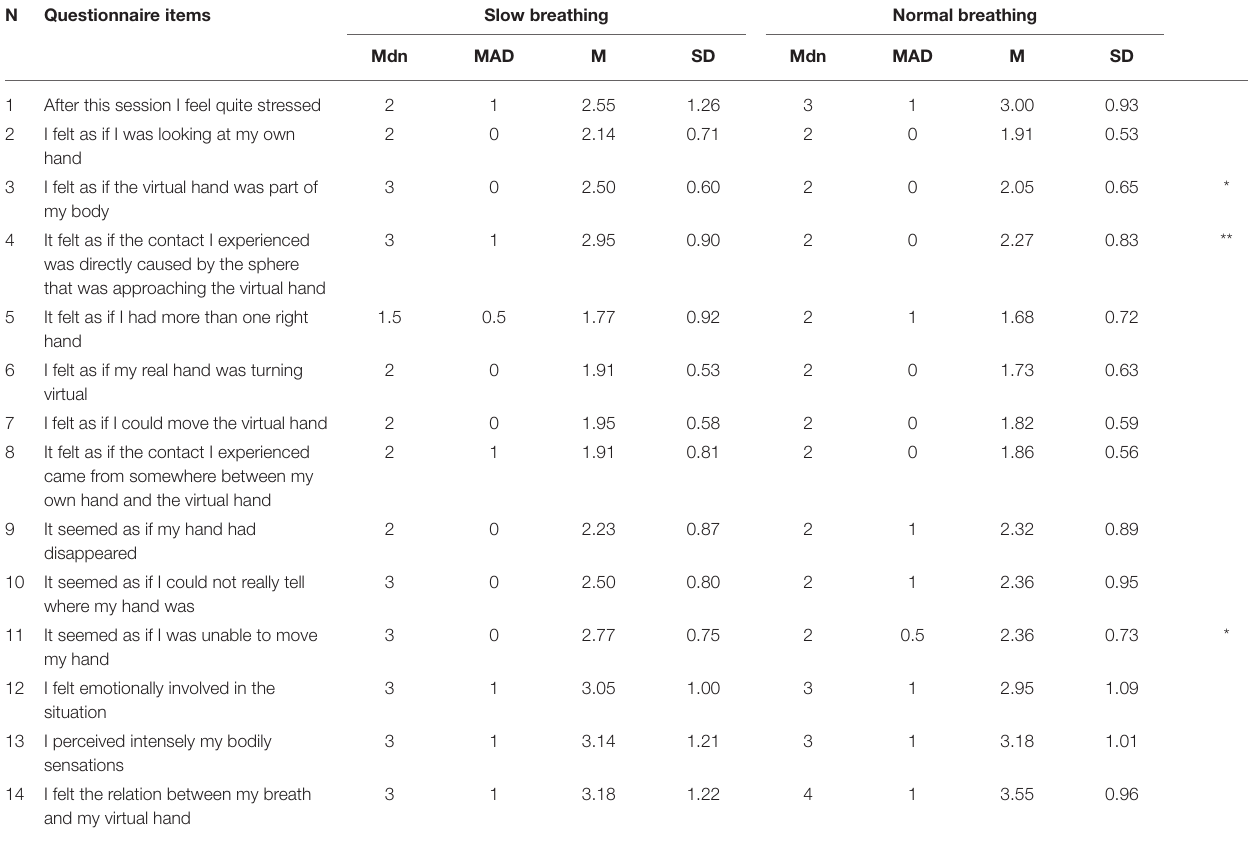
TABLE 1 | Subjective questionnaire scores (median, Mdn; median absolute deviation, MAD; mean, M; standard deviation, SD). N Questionnaire items